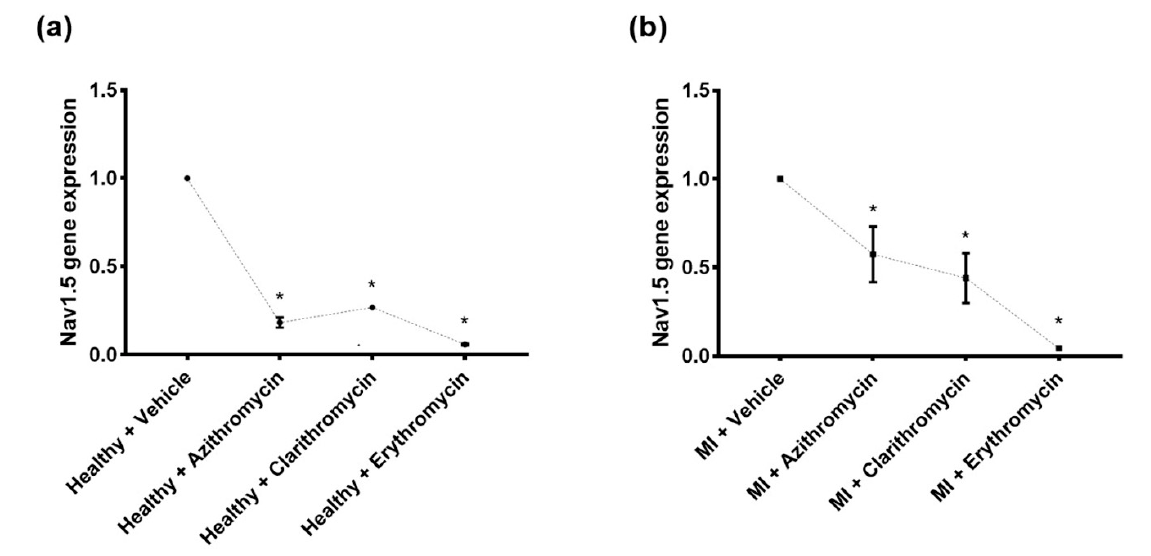
Figure 7. Cardiac SCN5A gene expression analysis in the study rat groups. Glyceraldehyde-3-phosphate dehydrogenase ( GAPDH) was applied as an endogenous control in Real-Time PCR runs for data normalization. Relative quantification of the SCN5A gene expression was done based on the quantitative cycle (Cq) values generated from the PCR with the equation: 2 −ΔΔ Cq where ΔΔ C q (delta delta quantitative cycle) = (C q SCN5A − C q GAPDH ) MI group − (C q SCN5A − C q GAPDH ) Healthy control [13]. ( a ). Normal rats were subjected to azithromycin, clarithromycin, and erythromycin (200 mg/kg for each drug) versus normal rats without treatment (healthy control). ( b ). Rats with induced myocardial infarction (MI) subjected to treatment with the same antibiotics versus the MI control group. The mean value of the controls in each group was set at value 1. * Significantly different from saline group in panel ( a ) ( p -values < 0.001), * Significantly different from MI group in panel ( b ) ( p -values < 0.001).